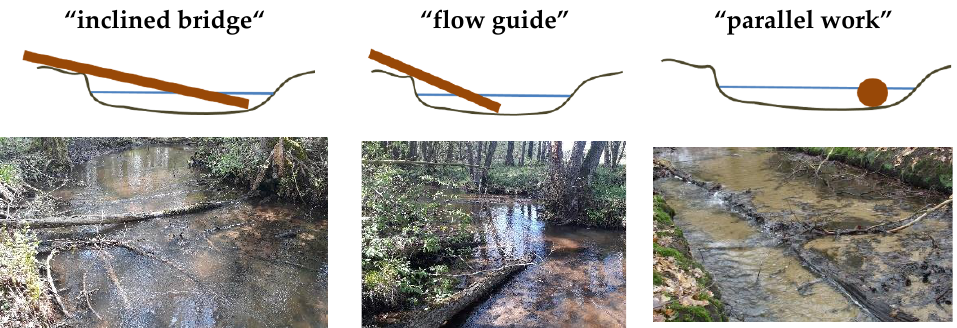
Figure 2. Schematic sketch and photos of three frequent deadwood structures [11,12], modified, adapted with permission from photographer, Michael